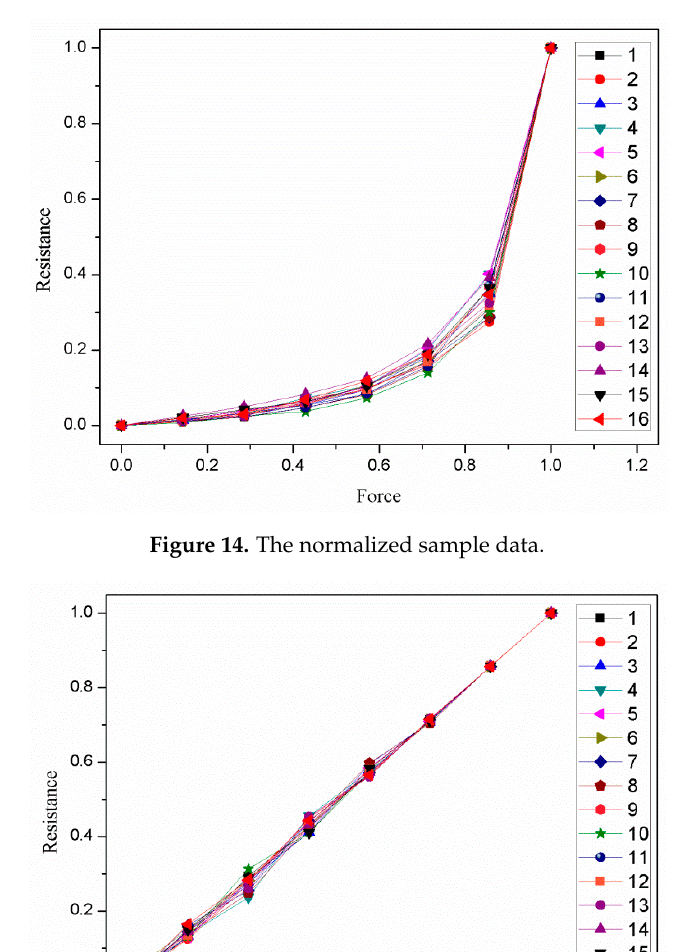
Figure 15. The output of the trained RBF neural